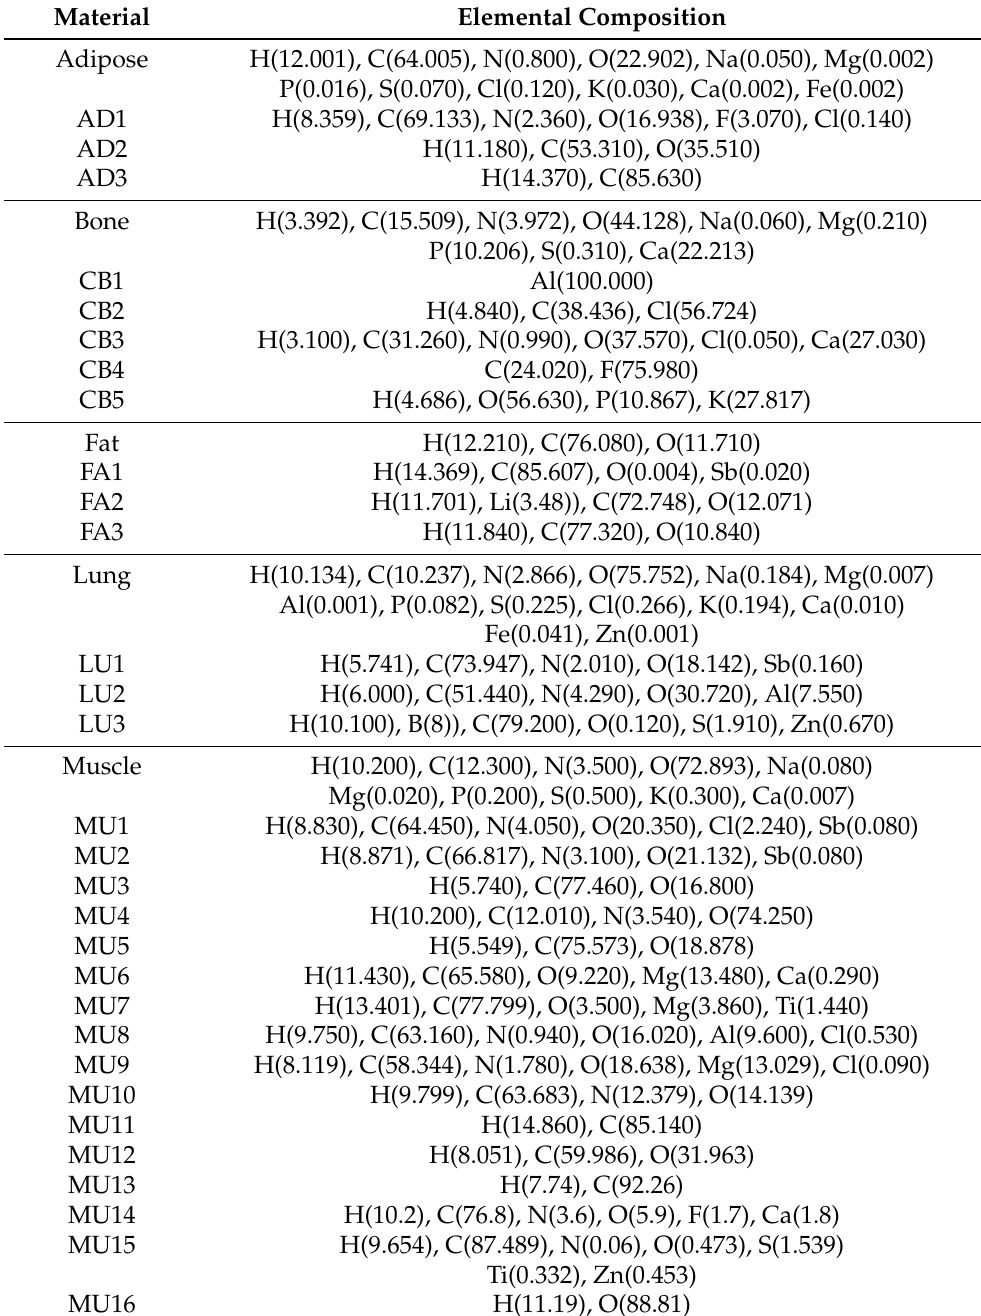
Table 1. Percentage elemental composition of studied tissues and their equivalent material